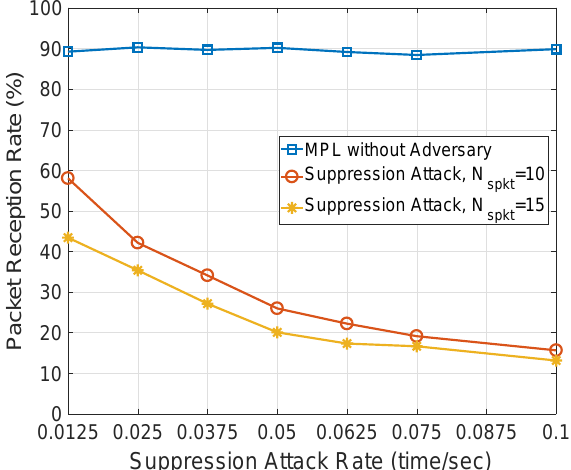
Figure 3. The packet reception rate against suppression attack rate and number of spoof data messages ( N spkt ). Here, we consider a network area (150 × 150 (m 2 )), where 51 nodes including one source node and five malicious nodes are uniformly